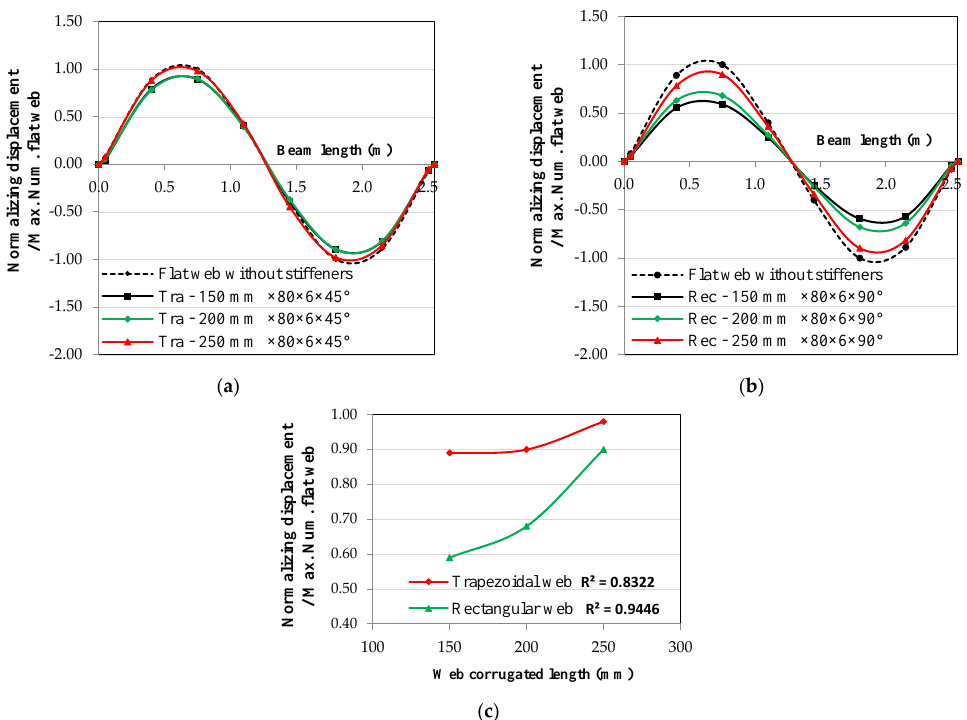
Figure 16. Corrugated length effect on the relationship between normalized displacement and beam length for the 2nd mode shape: ( a ) trapezoidal web, ( b ) rectangular web, and ( c ) length effect at the 2nd mode shape.